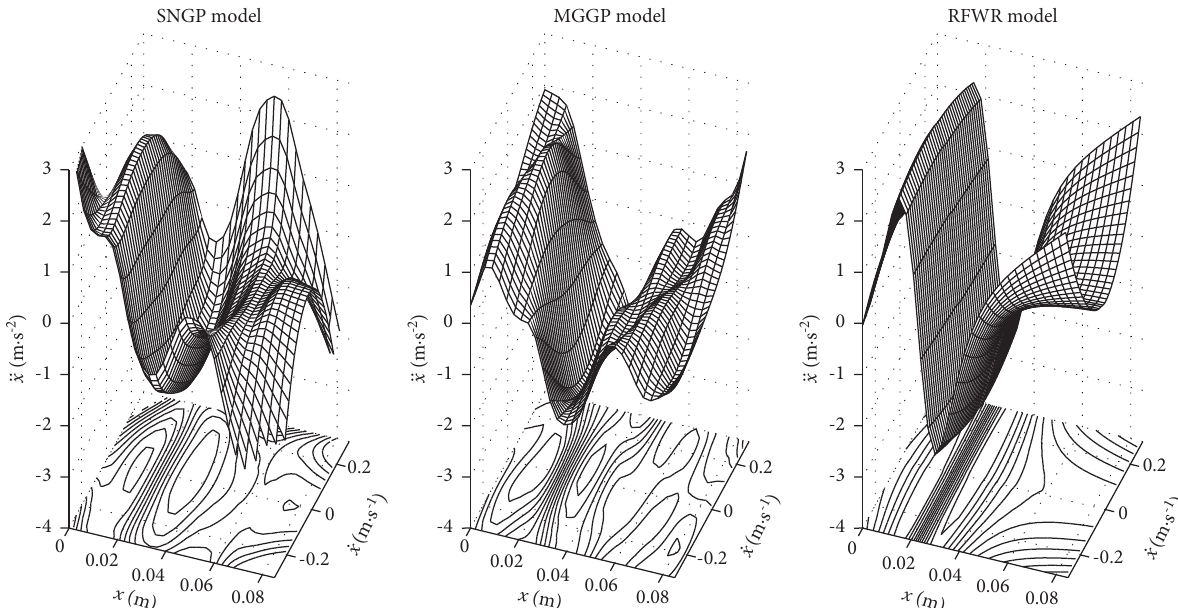
Figure 5: Comparison of approximated dynamic models for the SNGP, MGGP, and RFWR method, best-fitting models from each category. The 3D visualization is shown for constant input u � [ 0 , 0 . 6 ] T .